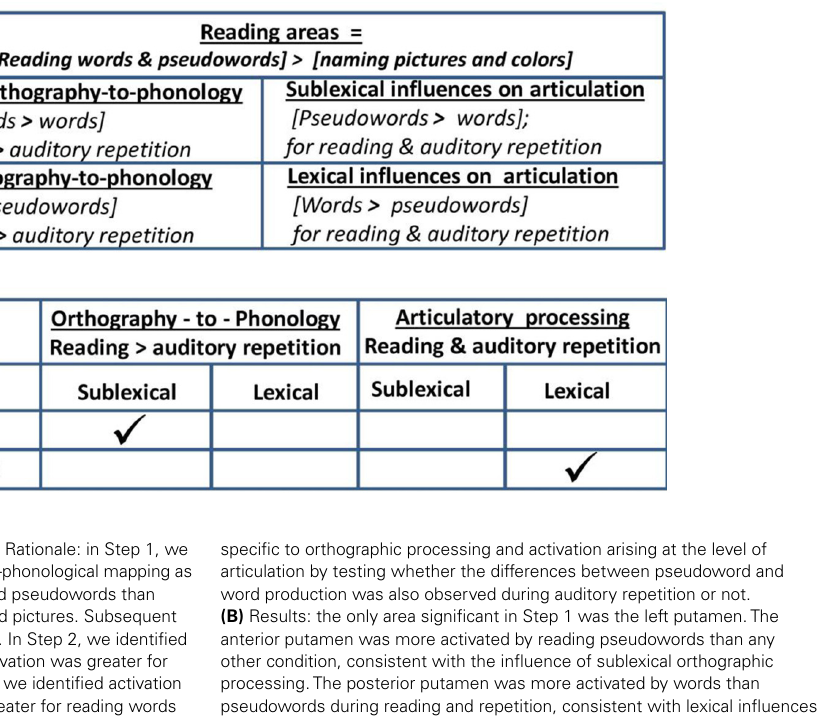
FIGURE 1 | Rationale and summary of results. (A) Rationale: in Step 1, we identified areas that were involved in orthographic-to-phonological mapping as those that were more activated by reading words and pseudowords than naming objects in pictures and the color of scrambled pictures. Subsequent analyses were restricted to these regions of interest. In Step 2, we identified activation increases for sublexical reading where activation was greater for reading pseudowords than reading words. In Step 3, we identified activation increases for lexical reading where activation was greater for reading words than pseudowords. In Step 2 and Step 3, we distinguish activation that is